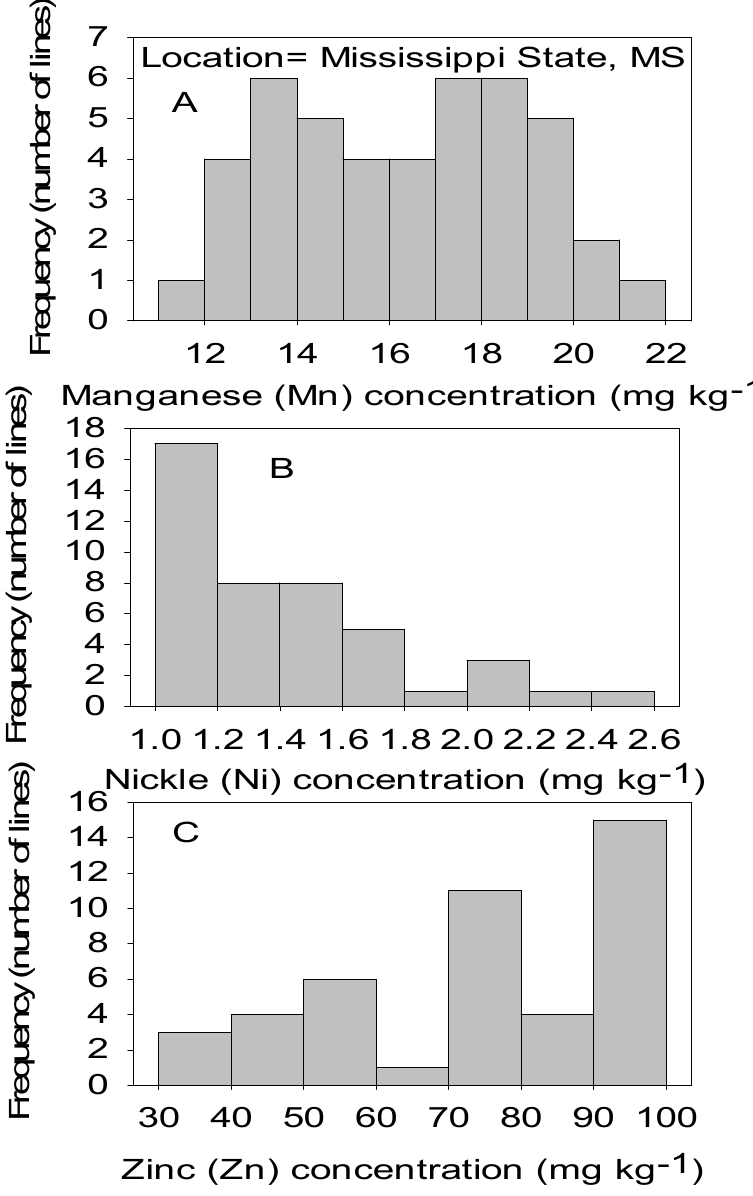
Figure 4. Distribution of micronutrients Mn ( A ), Ni ( B ), and Zn ( C ) in cottonseed in CS lines in cotton in Mississippi, MS, USA.